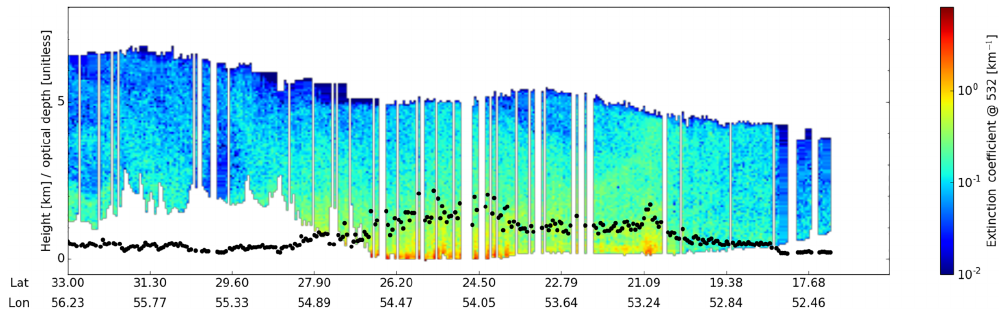
Figure 3. Curtain plot of the CALIOP extinction coefficient for heights identified as dust. The black dots are the column optical depth at 532nm from CALIOP. The curtain is for the CALIOP data between 40 and 60 ◦ E in the top plot of Fig. 2.